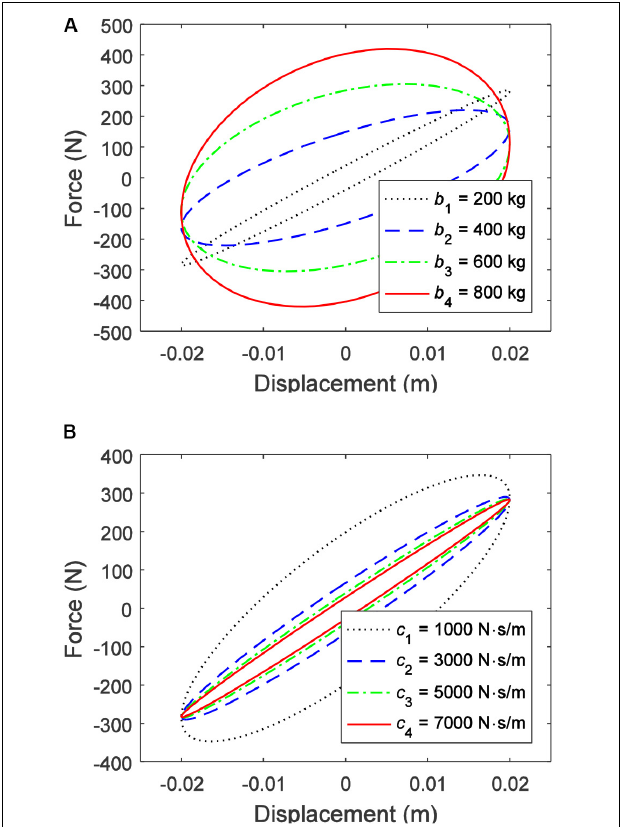
FIGURE 11 | Force–velocity characteristics of the integrated inerter-spring-damper: (A) different inertances and (B) different damping coefficients.